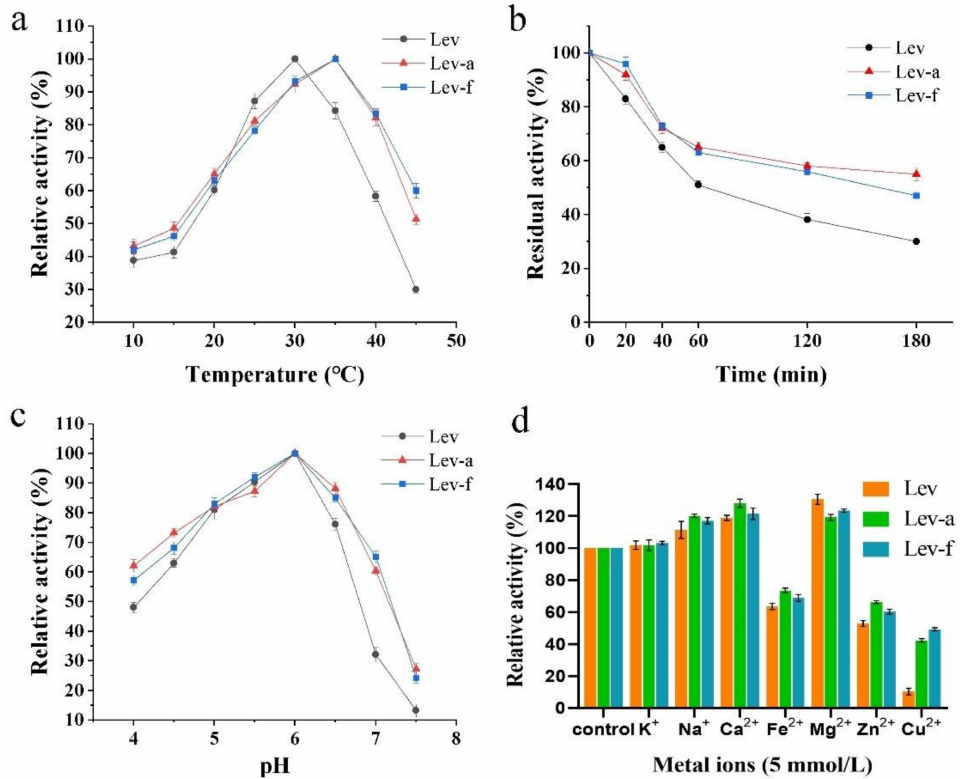
Figure 4. Effects of pH and temperature on the relative activity of S. cerevisiae cell surface displayed levansucrases and free levansucrase. ( a ) the relative activities along with different temperatures; ( b ) the thermal stabilities along with the time durations at 50 ◦ C; ( c ) the relative activities at different pH values; ( d ) effects of metal ions on the activity of levansucrases at 30 ◦ C and pH 6.0. Abbreviations: Lev, free levansucrase; Lev-a, levansucrase displayed with a-agglutinin; Lev-f, levansucrase displayed with Flo1p. (The maximum activity was taken as 100%; experiments were performed in triplicates, and error bars represent one Standard